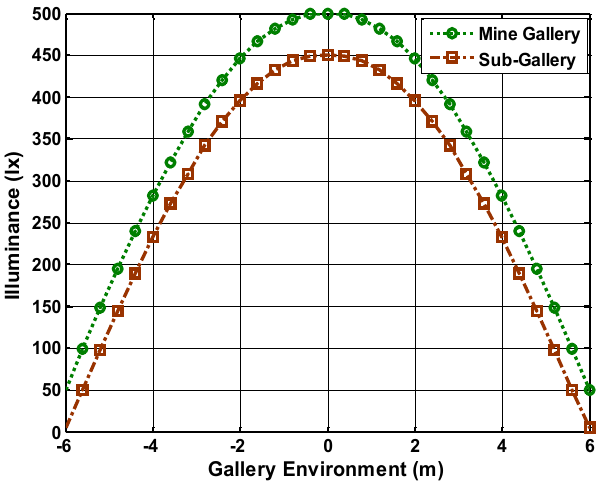
Figure 4. Distribution of horizontal illumination for mine gallery and sub-gallery